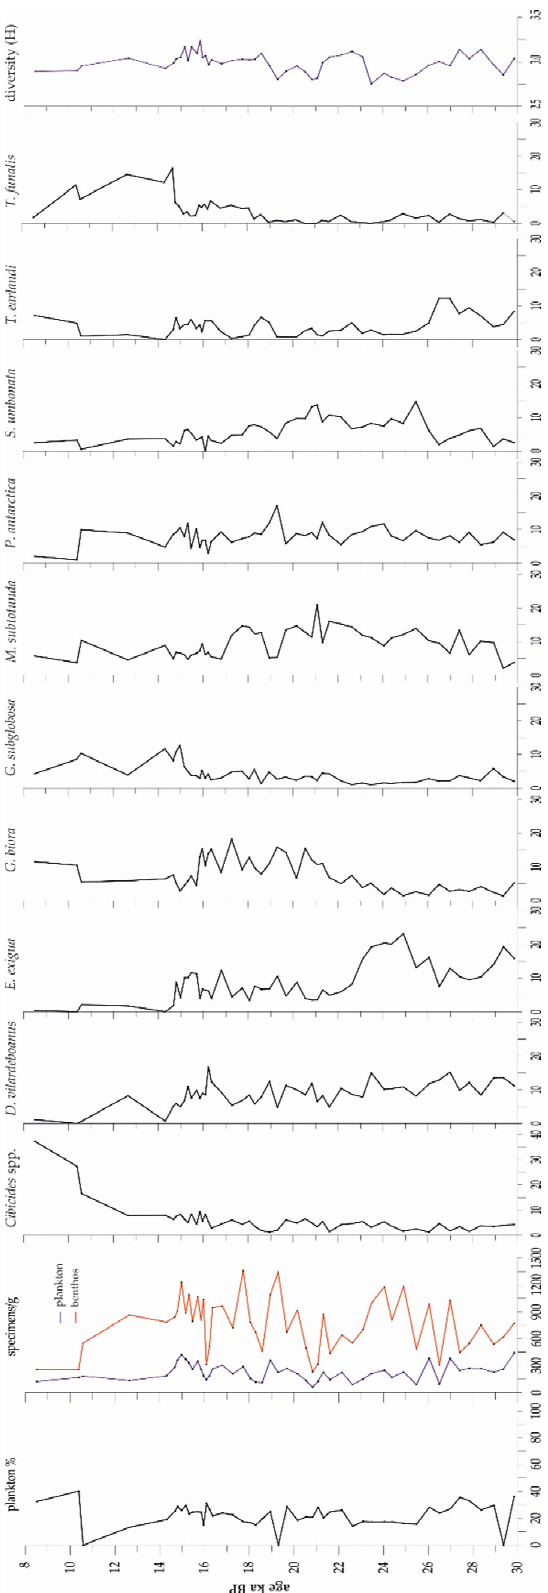
Figure 4. From left to right: down-core distribution of plankton %, plankton / g (in blue) and benthos / g (in red) of dry sediment, relative abundance (%) of significant benthic foraminifers and Shannon Diversity Index (H).